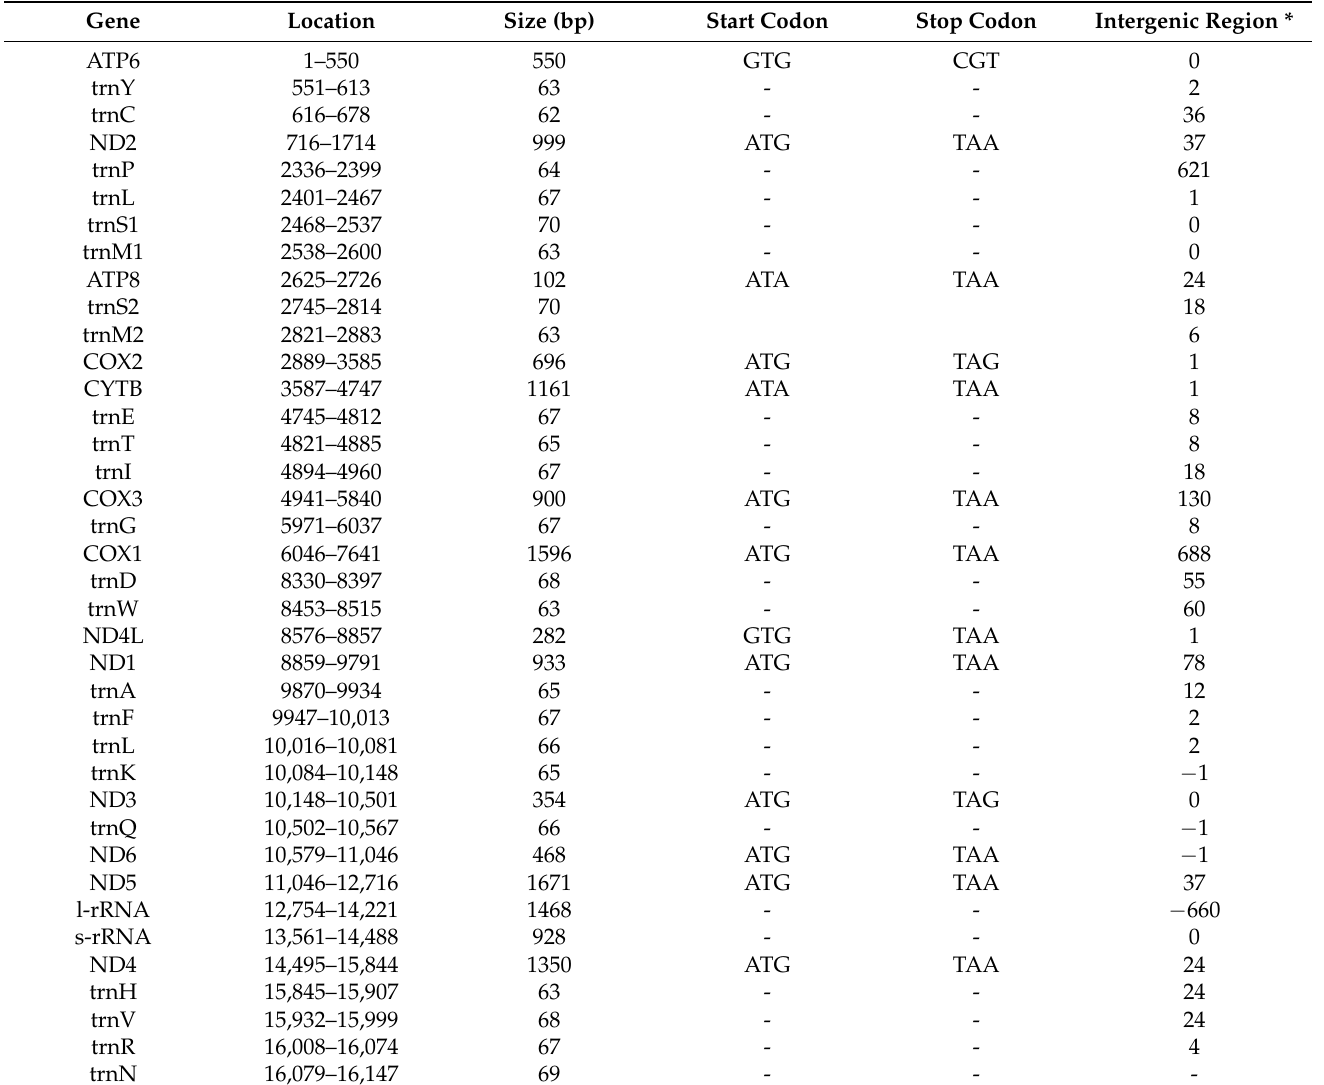
Table 2. Summary of Ostrea denselamellosa